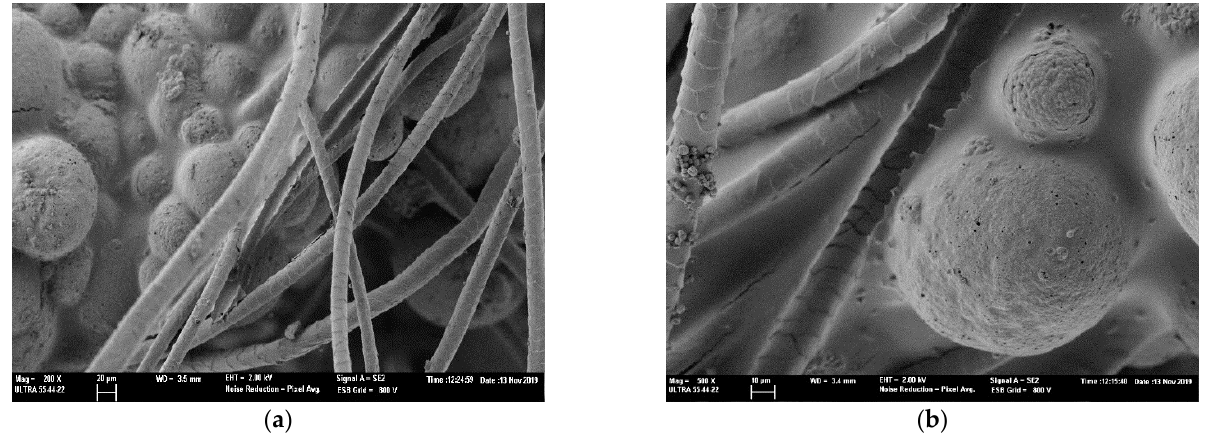
Figure 6. SEM images of PCM_41 specimen with magnification 200 × ( a ) and 500 × ( b ).